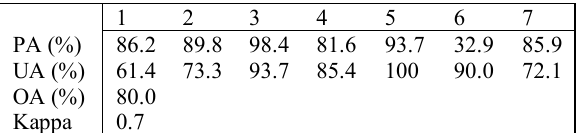
Table 4.2. Results obtained for 2017-year classification. PA: Producers Accuracy; UA: User’s Accuracy; OA: Total precision and Kappa classification.